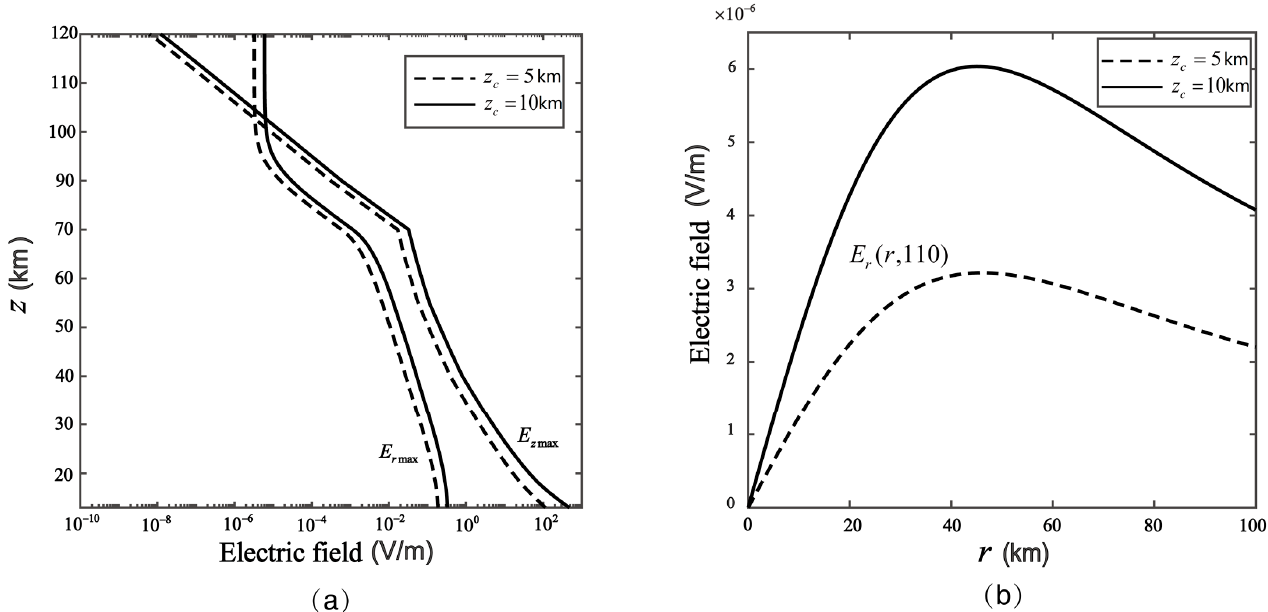
Figure 3. ( a ) The vertical distributions of the maximum vertical electric field E z max and the maximum horizontal electric field E r max . For all E z max , r is taken to be 0 km; and for charges located at 10 km and 5 km, the E r max horizontal distances are r = 44 km and 45 km, respectively. ( b ) The horizontal electric field intensity in the ionosphere at an altitude of z = 110 km.